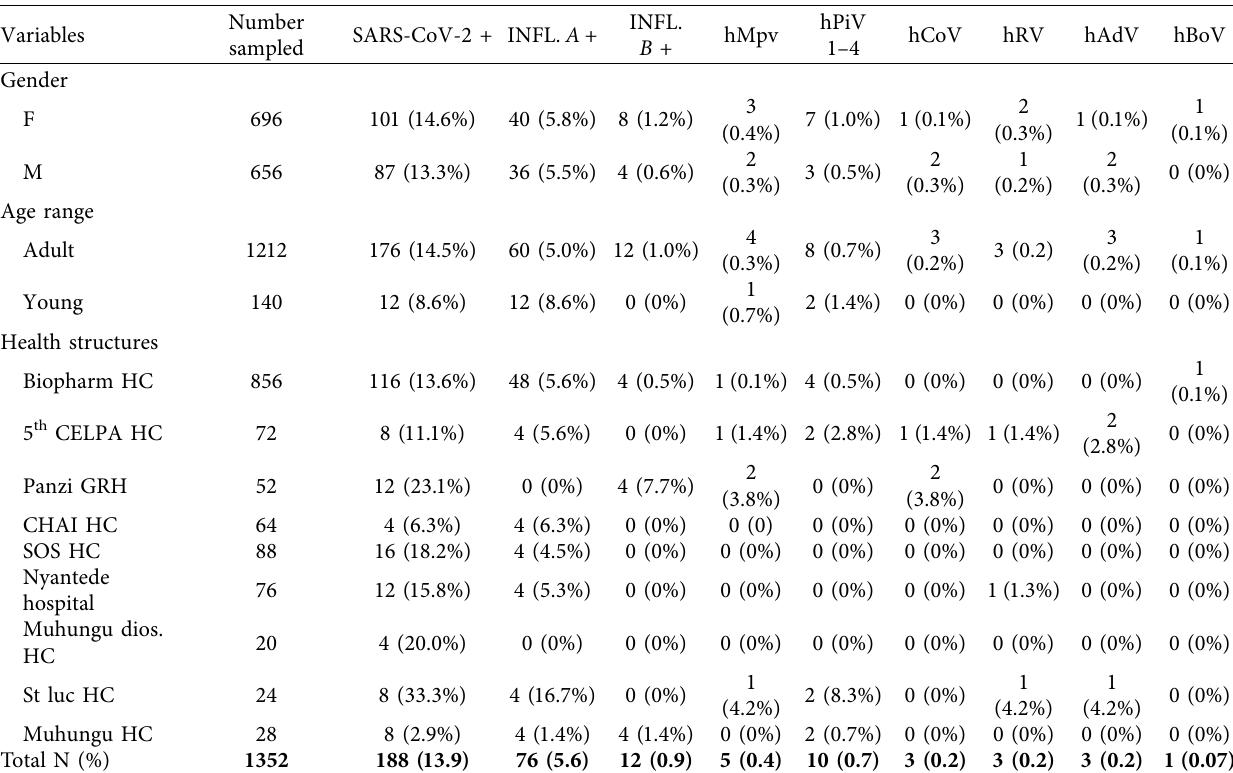
Table 1: Frequency of SARS-CoV-2 and other respiratory viruses detected according to sex, age, and health